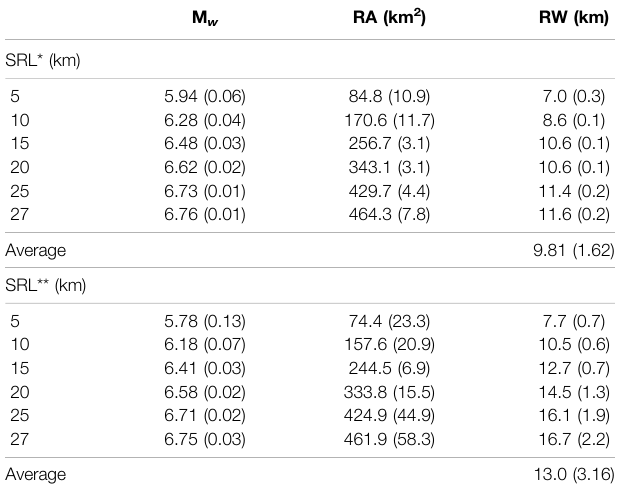
TABLE 5 | Values of maximum moment magnitude M w for each earthquake for selected surface rupture lengths (SRL), the associated rupture areas (RA) and rupture widths (RW) as given by Eqs 5 , 6 . 1 σ errors are reported in parentheses. * gives values for fault segment with pure strike-slip kinematics; ** gives values for fault segment with pure normal slip kinematics.